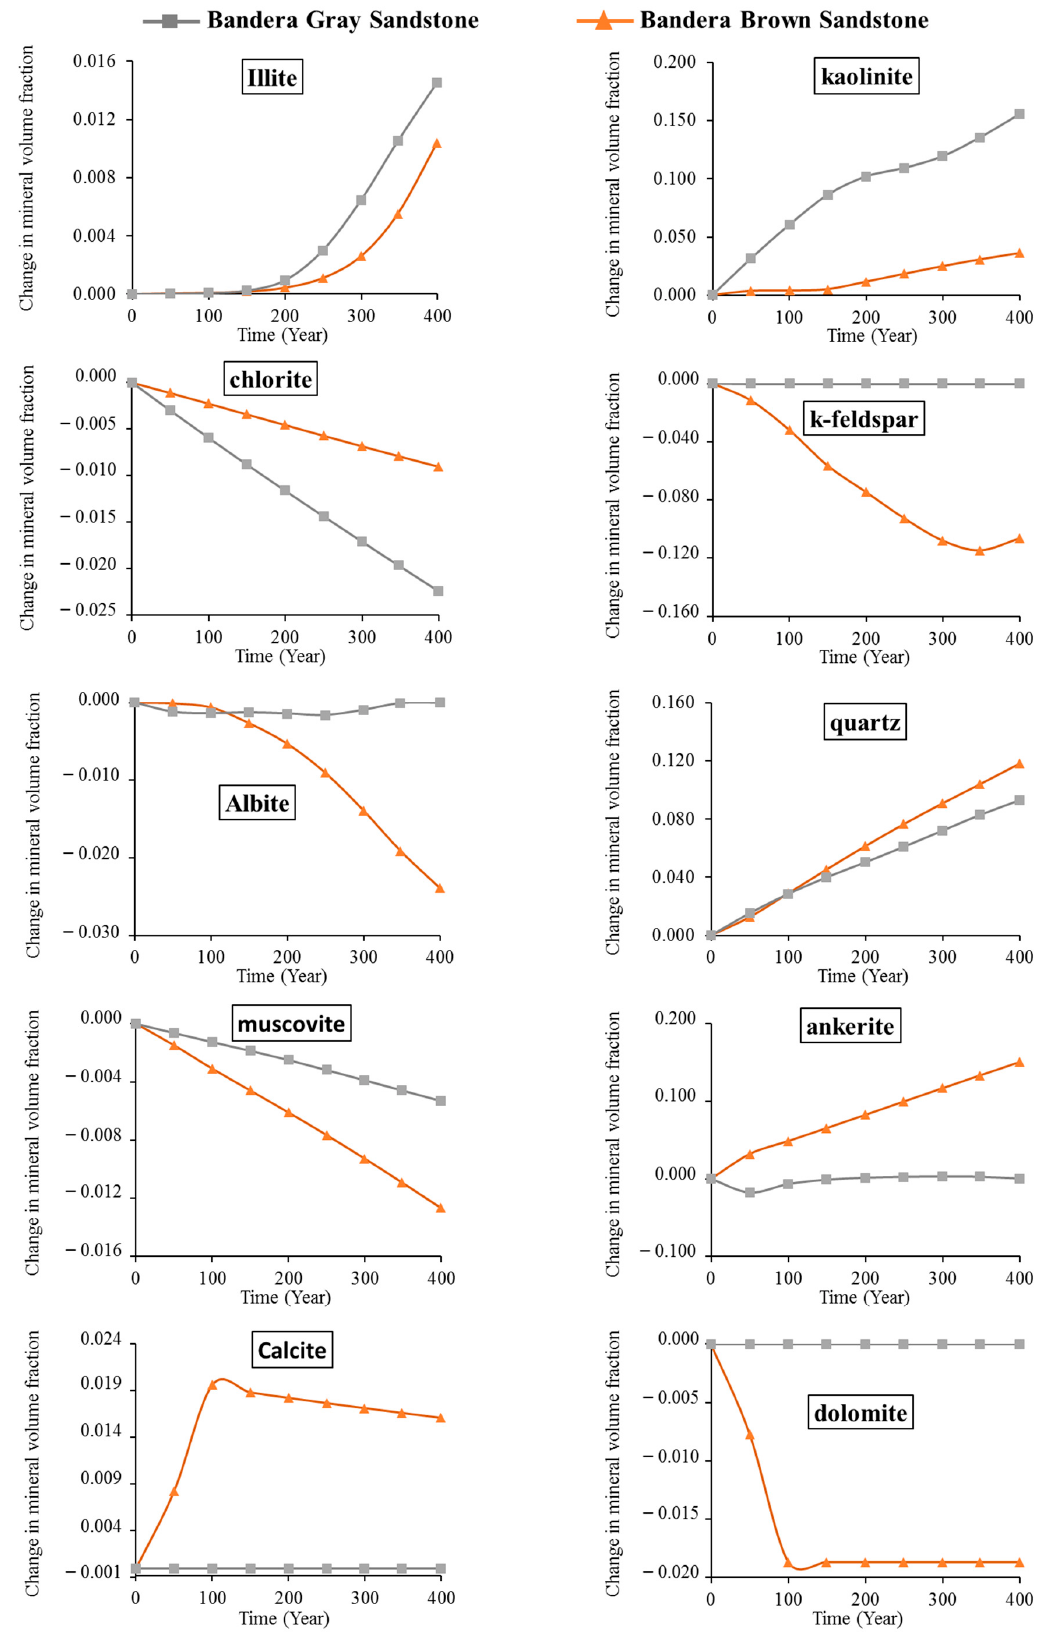
Figure 3. Changes in mineral abundance for di ff erent clay-content sandstones with storage time.